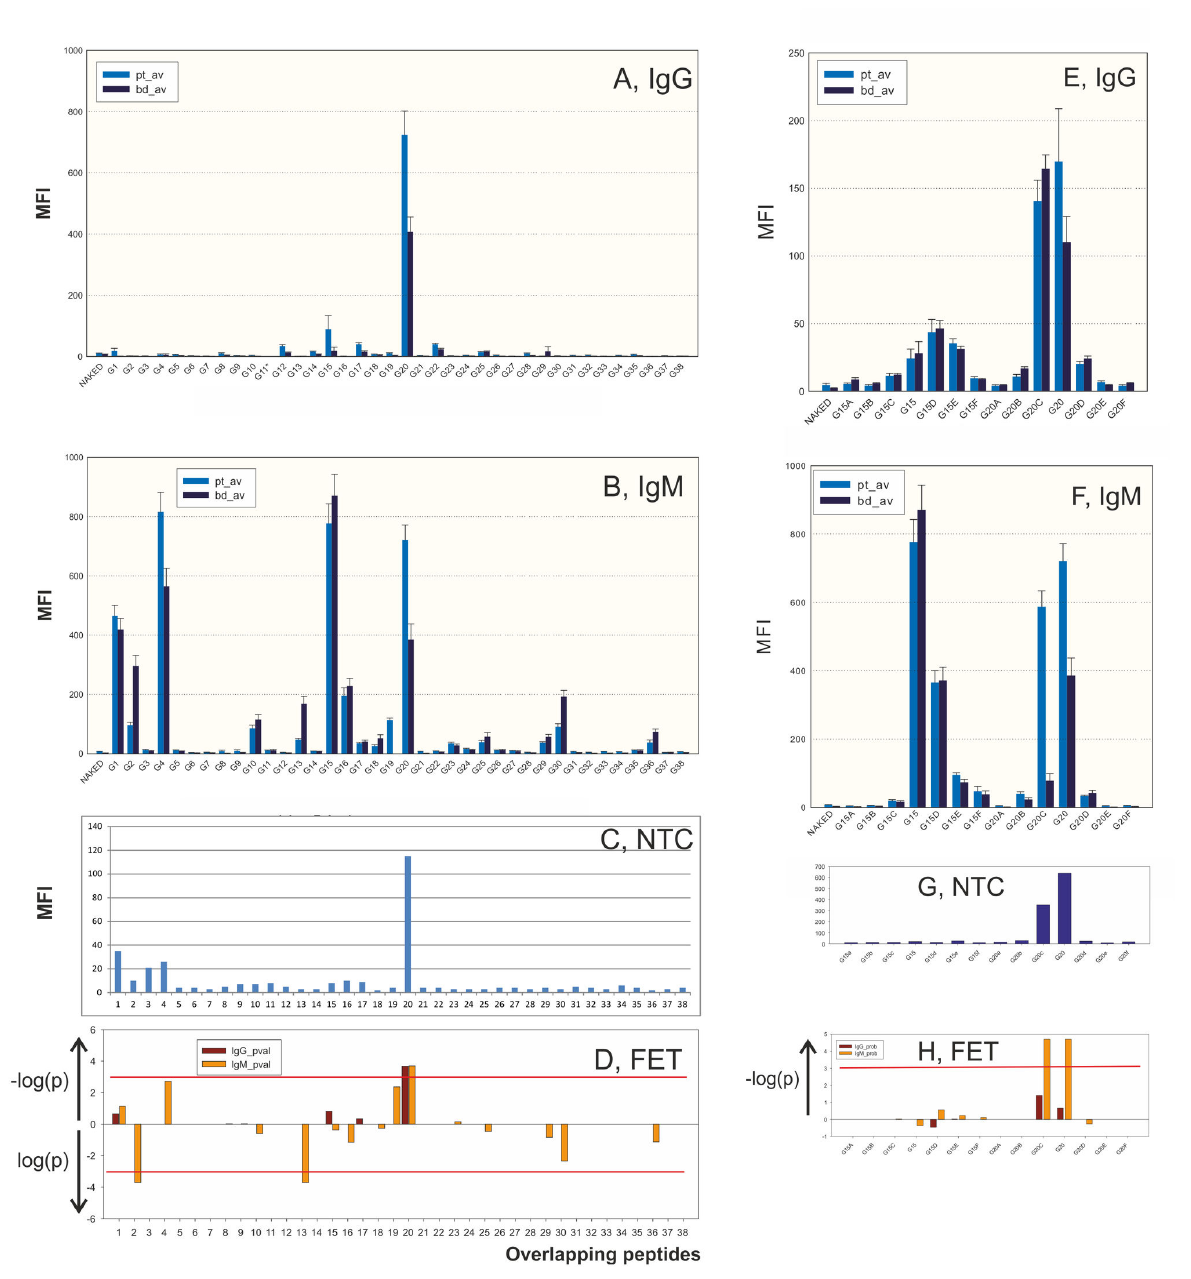
Figure 1. Comparison of IgG and IgM results. A-D: Epitope scanning with synthetic 30-mer peptides overlapping by 15 amino acids, from human HSP60. Peptides were covalently coupled to carboxylated color-coded beads. Binding values were partially subtracted with the non-template control (NTC) value. A. Averages of results with anti-IgG conjugate (protein G). B. Results with IgM (polyclonal anti-human IgM) conjugate. C. Binding of the detection components directly to beads, without presence of patient sample, the NTC. D. 10-logarithm of the p value from the Fischer Exact Test (FET). The upper arrow shows the p value of peptides with ME preference, the lower one shows the p value of peptides with BD preference. The red line denotes a p value of 0.001. Error bars denote standard error of the mean. The dark blue bars (pt_avg) denote averages from ME patient samples, the light blue bars (bd_avg) from BD. The abscissa shows results with successive overlapping peptides (G1-G38). E-H: Further epitope scanning of human HSP60. Peptide sequences were displaced three times, three amino acids at a time, either towards the amino end of human HSP60 (peptides a-c), or towards the carboxyl end (peptides d-f), starting either from peptide G15, or peptide G20. Abbreviations and conventions are as in A--D. doi: 10.1371/journal.pone.0081155.g001 PLOS ONE |